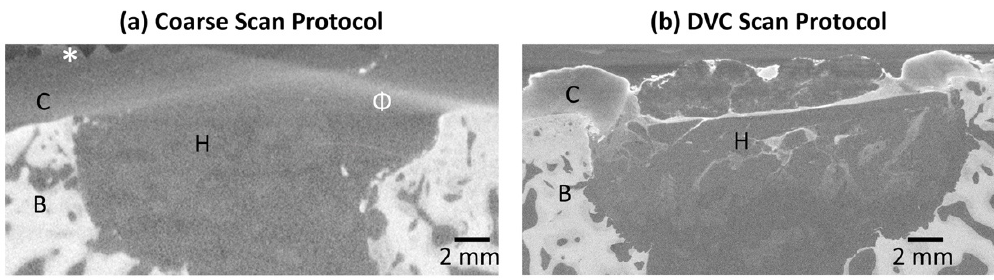
Figure 7. Transverse slices from two micro-CT scans of the sample following different scanning protocols: ( a ) the sample scanned in PBS on the day of retrieval with a preliminary coarse absorption contrast scan ( b ) the sample after reducing excess tissue around the perimeter, staining in 1% PTA and 70% ethanol and using a longer propagation phase contrast scanning protocol. Brightness and contrast have been approximately normalised. C = Cartilage region, B = Subchondral Bone, H = Hybrid scaffold implant. * = air bubbles relating to containment of the sample under coarse settings. Φ = beam hardening artefacts. Scale has been normalised between the two scans which were originally produced using different voxel sizes, see Table 1.